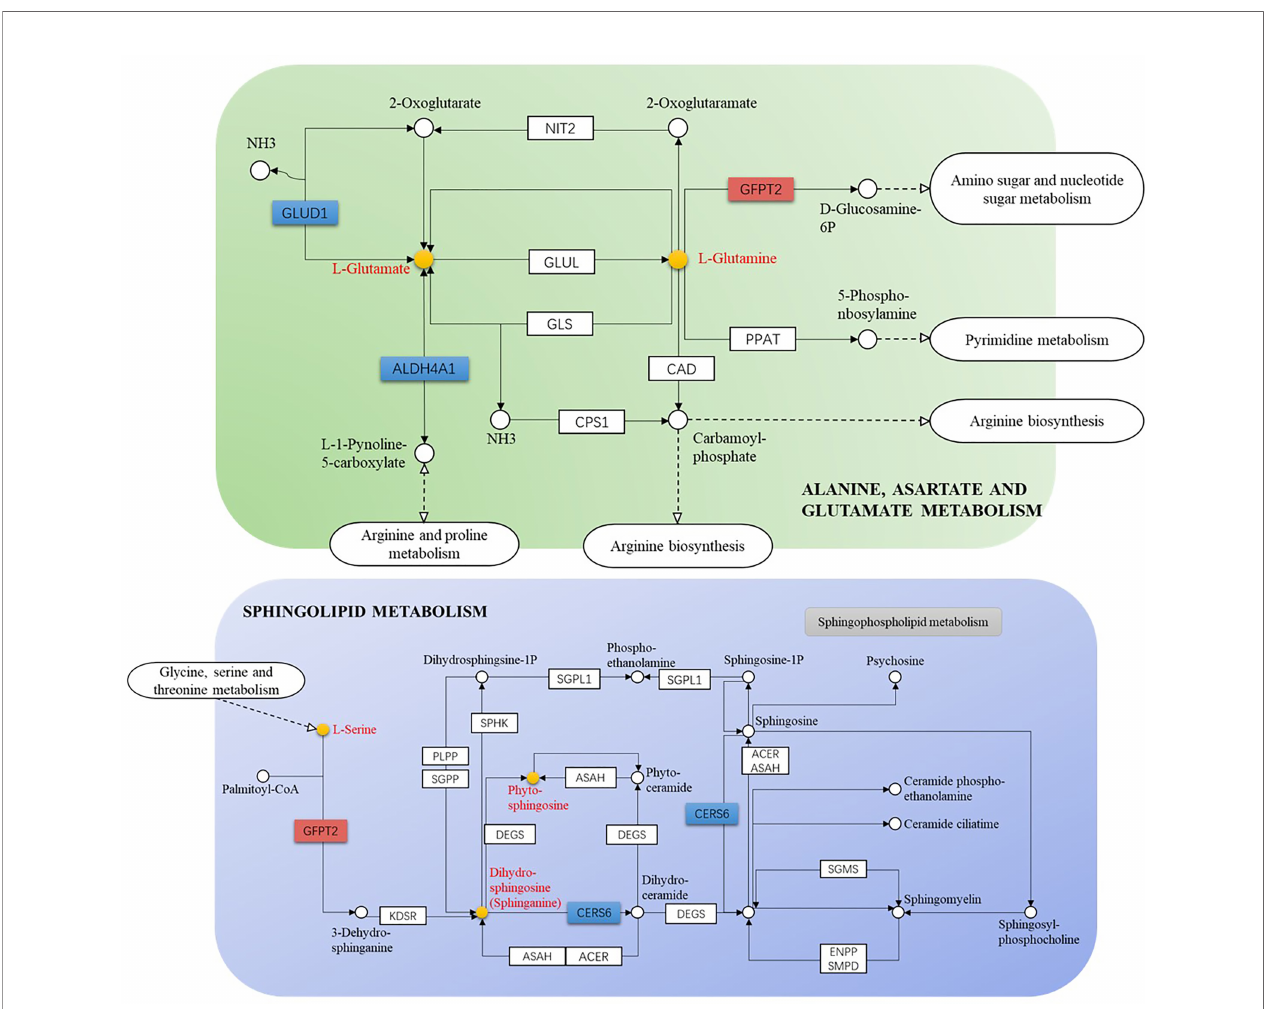
FIGURE 8 | Gene-metabolite connection network diagram (yellow circle: key metabolite, blue rectangle: key protein level decreased, orange rectangle: key protein level increased).